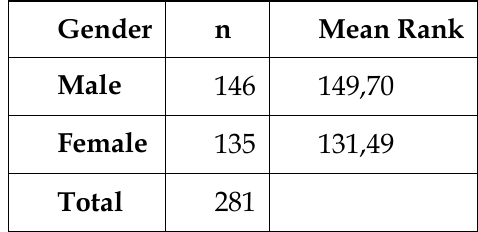
Table 12. Concern about breaching personal privacy and gender. Mann-Whitney U mean